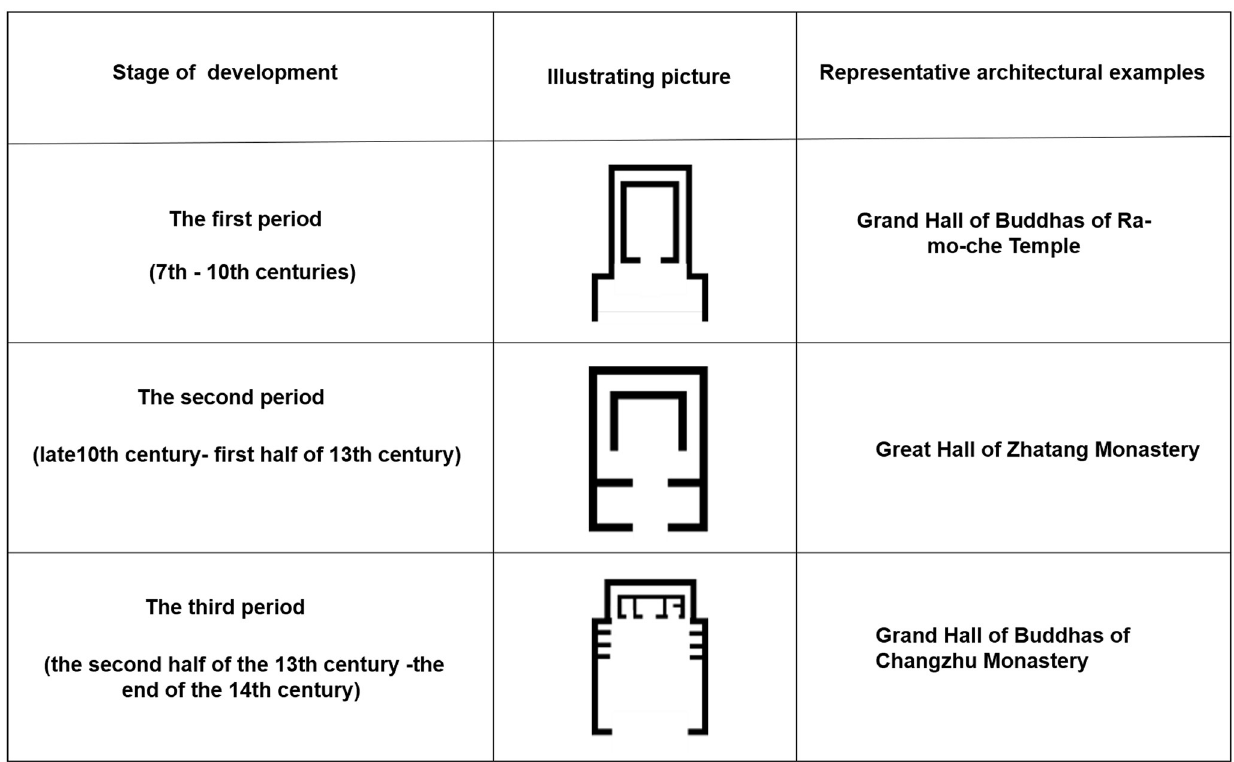
Fig 5. Evolution of palace buildings in Tibetan monasteries (from the 7th to 20th